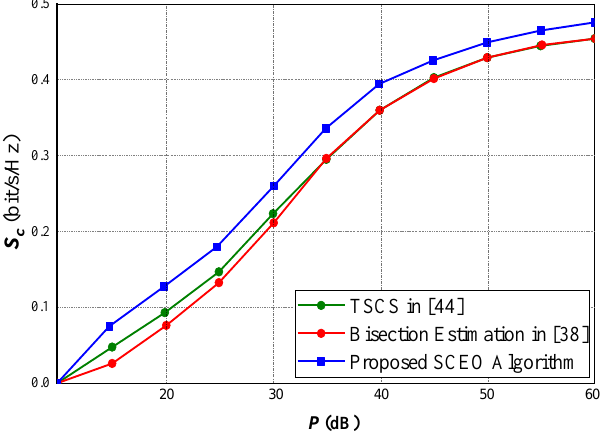
Figure 9. Performance of the algorithms under different power